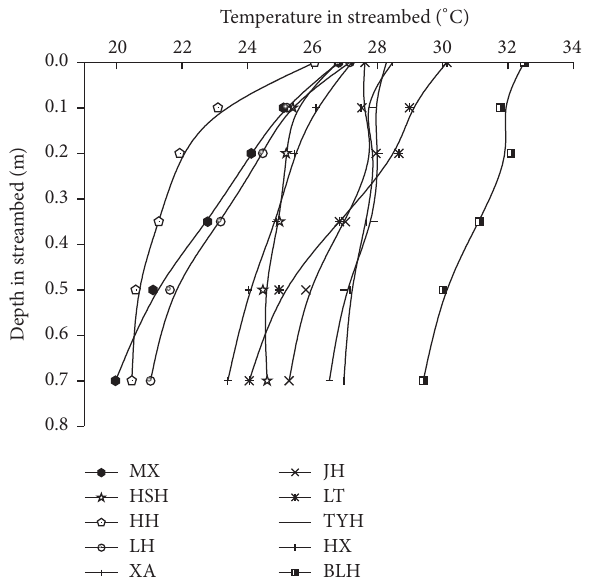
Figure 6: Temperature profiles of streambed sediment in testing